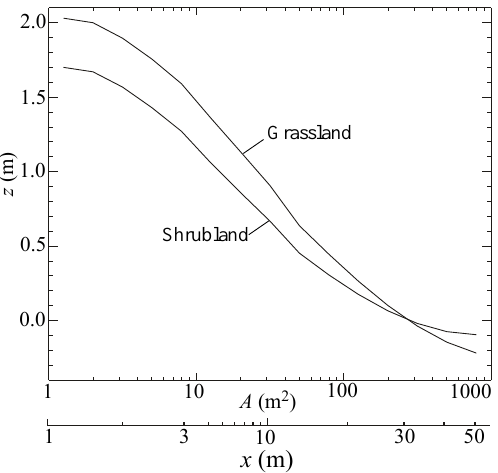
Figure 11. Plots of the mean longitudinal profile of hillslopes and valley bottoms in shrubland and grassland areas, constructed by in- tegrating the mean curvature data in Fig.